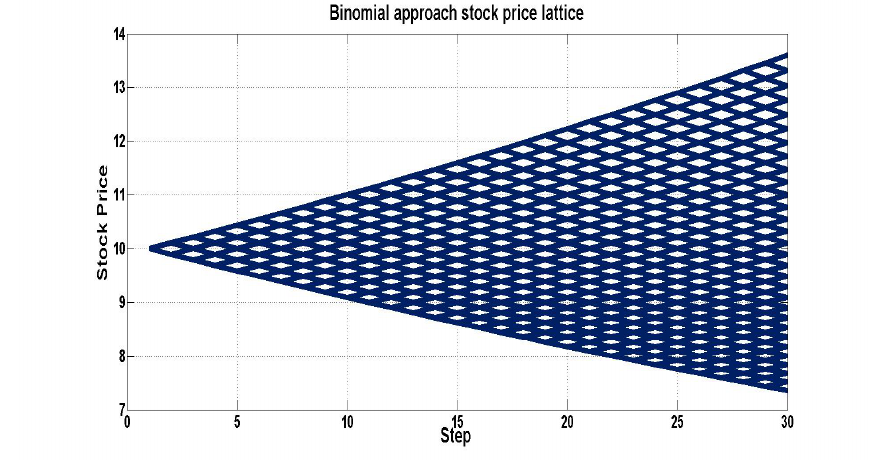
Figure 8. Stock price binomial lattice with parameters: u = 1 . 039576 , d = 0 . 962091 , P ( up ) = 0 . 5 and n = 30 .